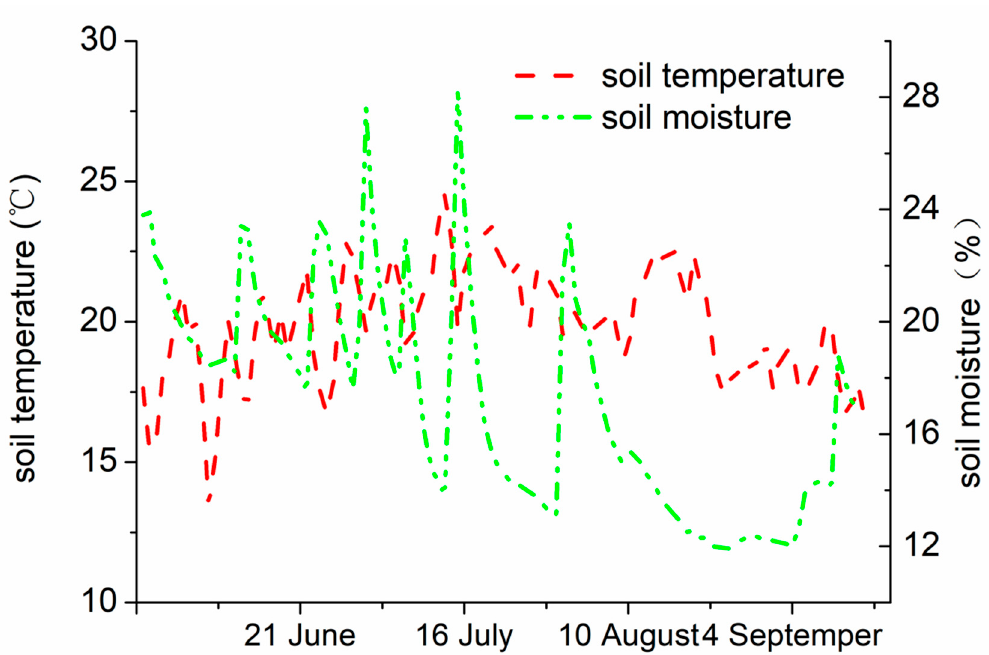
Figure 7. Relationship between soil moisture and temperature during potato growth period at 10-cm depths in 2017 under W2 treatment.